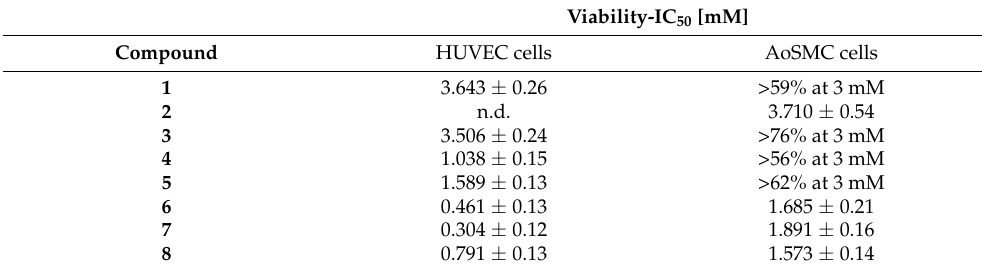
Table 1. The effects of sulfonamides 1 – 8 on HUVEC and AoSMC cells growth. The results (IC 50 values, mM) are presented as mean ± SD ( n = 6–8).